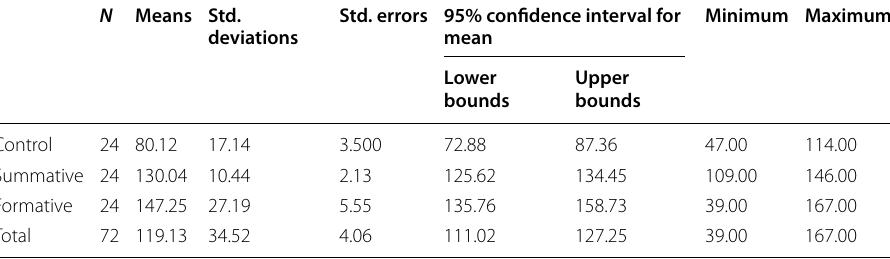
Table 8 Descriptive statistics of the three groups on the self-regulation post-tests N Means Std. Std. errors 95% confidence interval for deviations